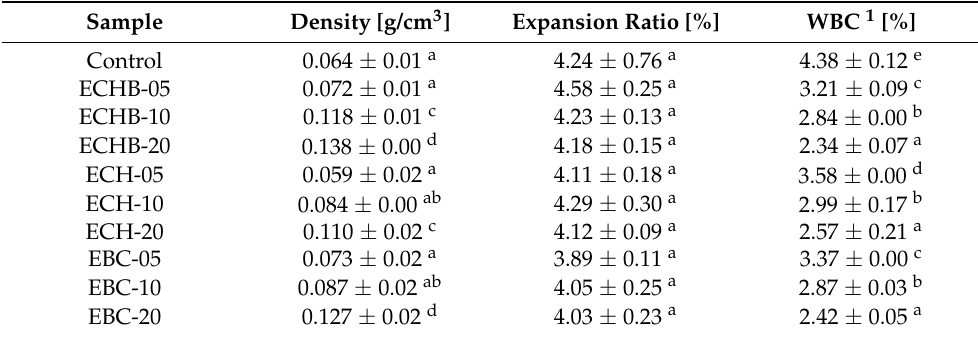
Table 5. Physical properties of extrudates of corn extrudates with addition of fruit pomace.